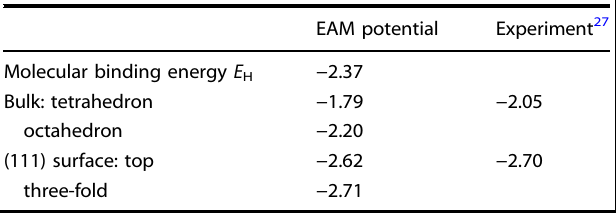
Table 1. H trapping sites and binding energy (eV per atom) EAM potential